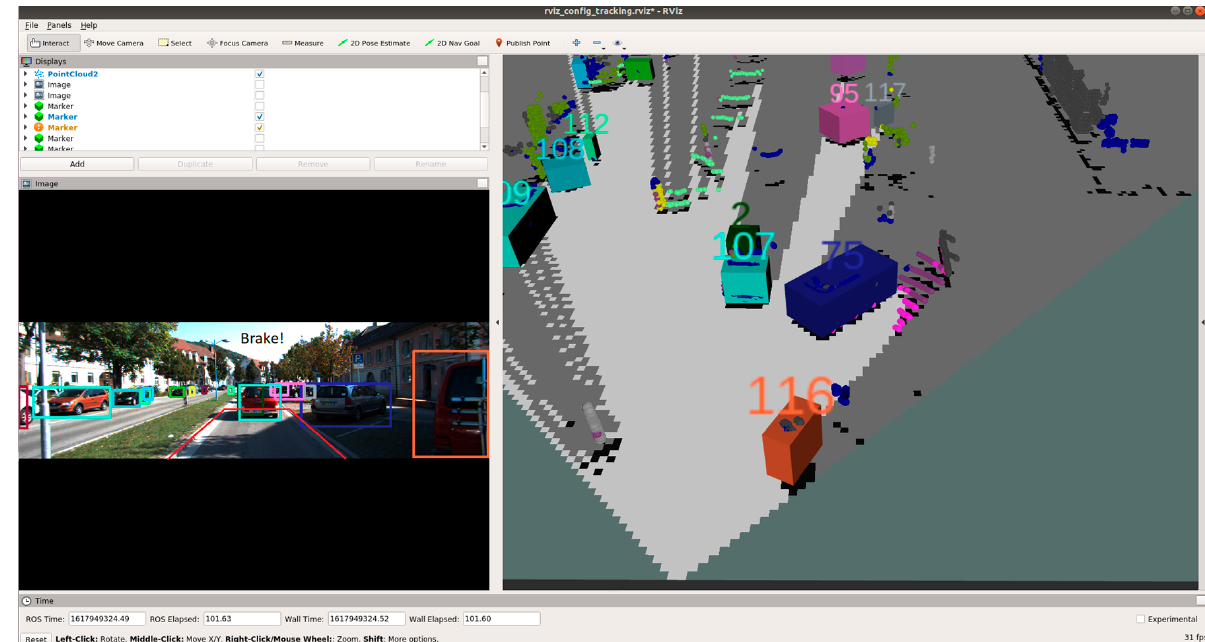
Figure 21. Unsafe scenario as detected by OCSF-driven EBA (object IDs are depicted above the 3D bounding boxes).